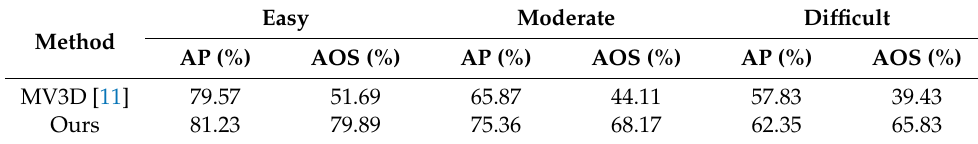
Table 4. Test results on samples with different difficulty